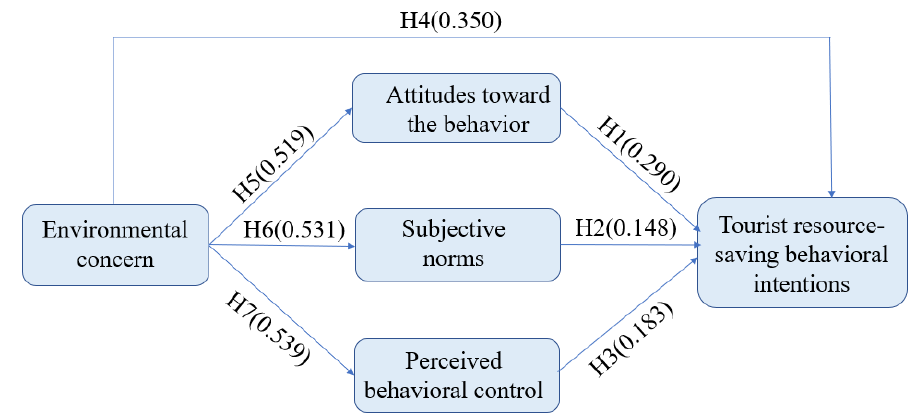
Figure 2. AMOS output results.